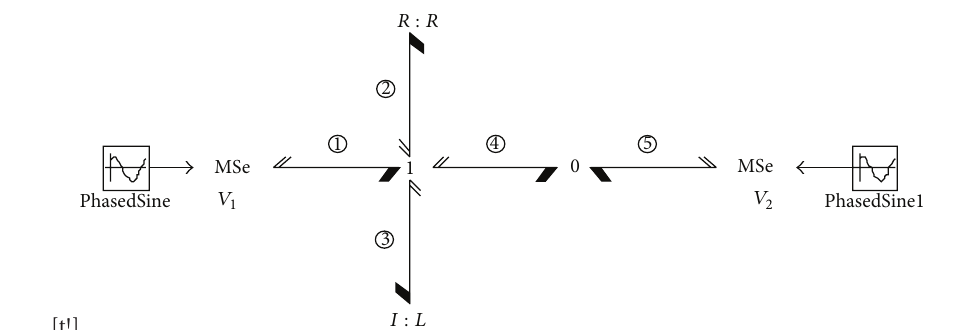
Figure 15: StBG of two interconnected sources.